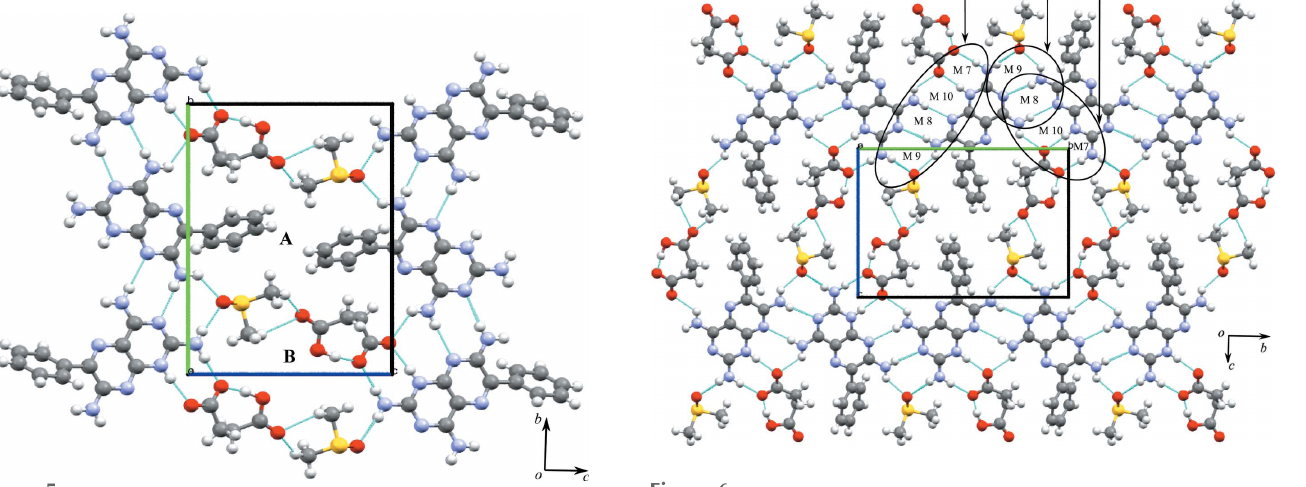
Figure 6 Motifs M7, M10, M8 and M9 (TM18), M8 and M9 (TM19), and M7, M10 and M8 (TM20) observed in the hydrogen-bonded sheets of 1b (cid:3)